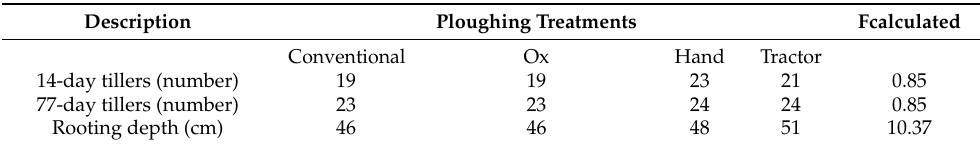
Table 2. Mean number of tillers and rooting depth for different ploughing